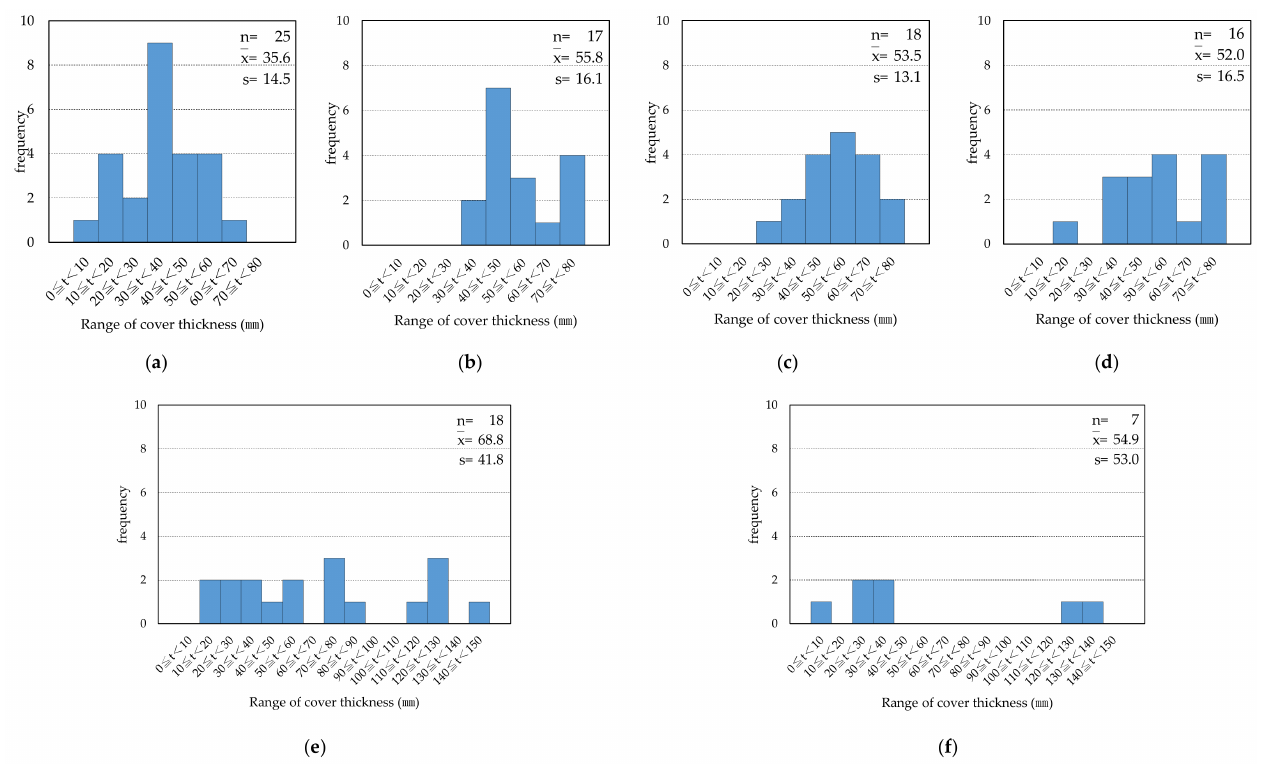
Figure 4. Distribution of cover thickness for each building: ( a ) Bldg. A; ( b ) Bldg. B; ( c ) Bldg. C; ( d ) Bldg. D; ( e ) Bldg. E; ( f ) Bldg. F. Where n: number of samples, x: mean value, s: standard deviation.